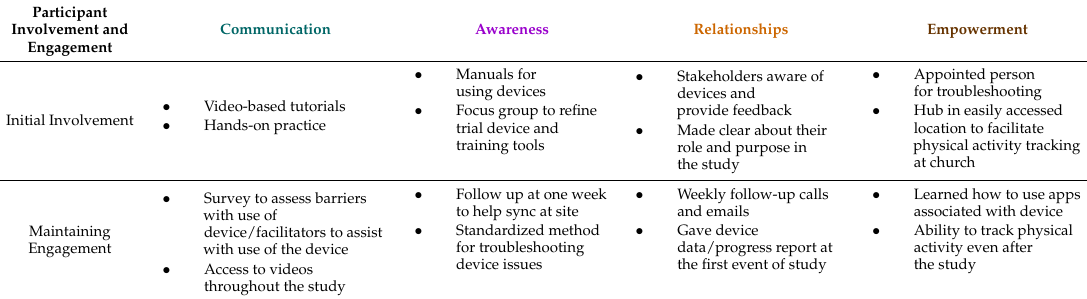
Table 2. C.A.R.E. Model as a useful tool for mHealth technology. The C.A.R.E strategies were important for introducing and maintaining engagement with mobile health